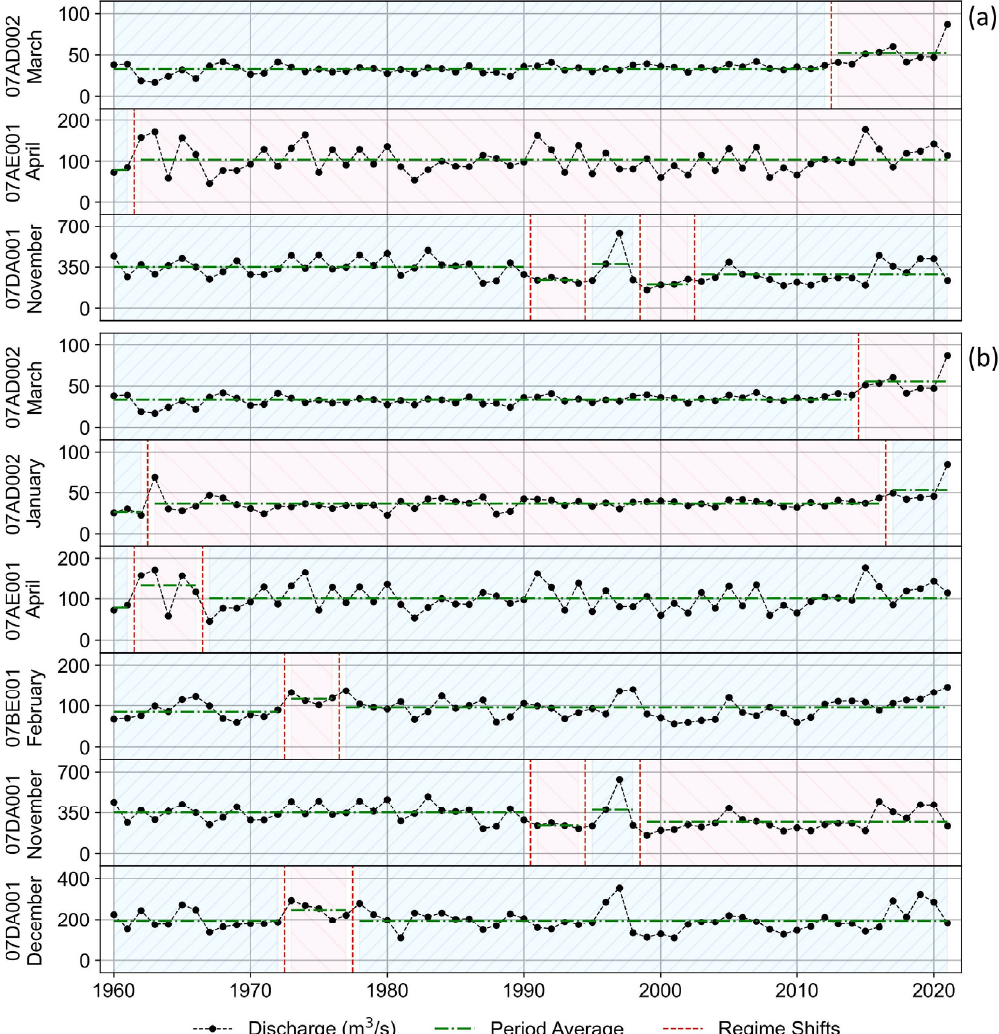
Figure 6. RSCD Results for cold months using Growth Rate ( a ), Relative Difference ( b ), and a 30-year (1961–1990) period for calculating µ and σ , and ε thresholds from Table 2. The streamflow (m3/s) is shown on the y -axis in each panel. The use of red and blue shades aids in distinguishing between the di ff erent regimes.